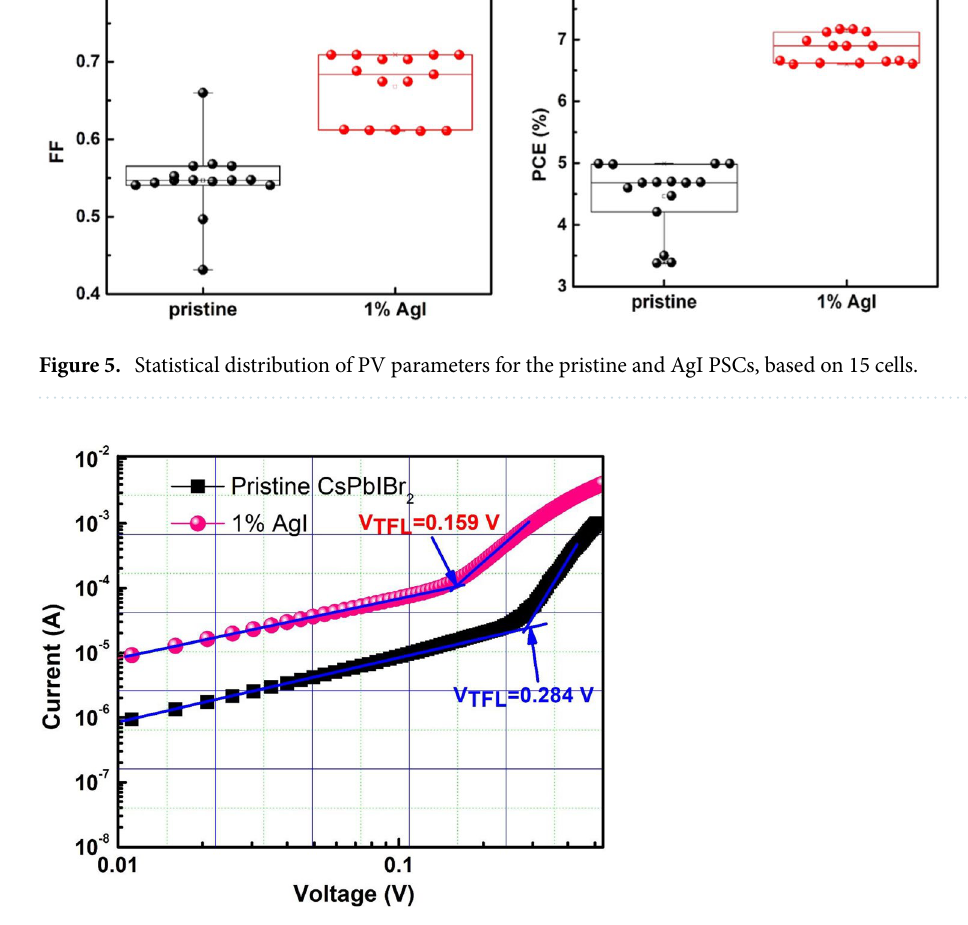
Figure 6. Hole-only devices films (FTO/PEDOT: PSS/CsPbIBr 2 /P3HT/Ag) for pristine, and 1% AgI CsPbIBr 2 perovskite